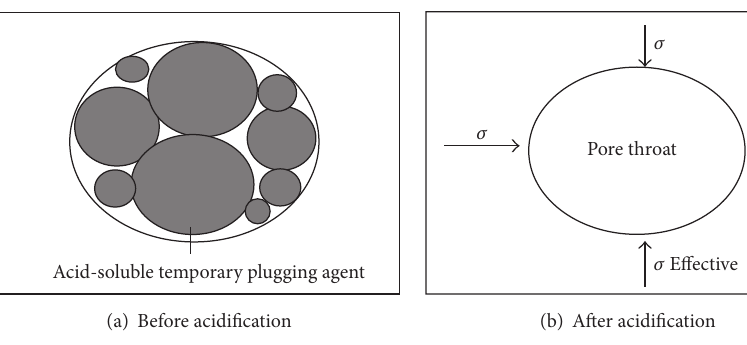
Figure 4: Pore throat characteristics before and after dissolution of the temporary plugging agent in